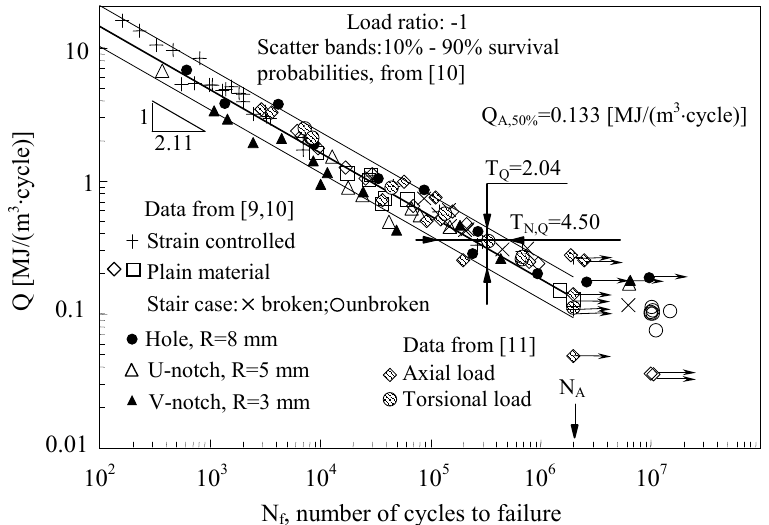
Figure 2: Fatigue data shown in Fig. 1 analysed in terms of energy released as heat by a unit volume of material per cycle. Scatter bands are defined for 10 and 90% survival